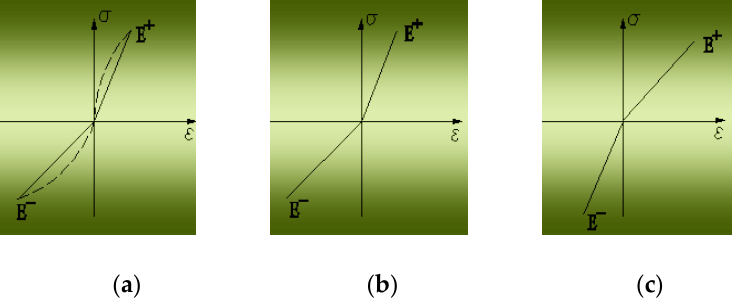
Figure 1. Constitutive model for bimodular materials: ( a ) nonlinear model under actual state; ( b ) bilinear model when E + > E − ; ( c ) bilinear model when E + < E − .